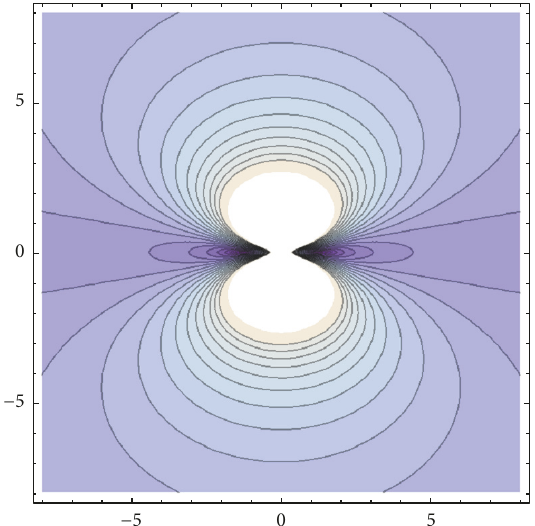
Figure 22: Contour of the rouge wave structure determined by the module of solution (84).